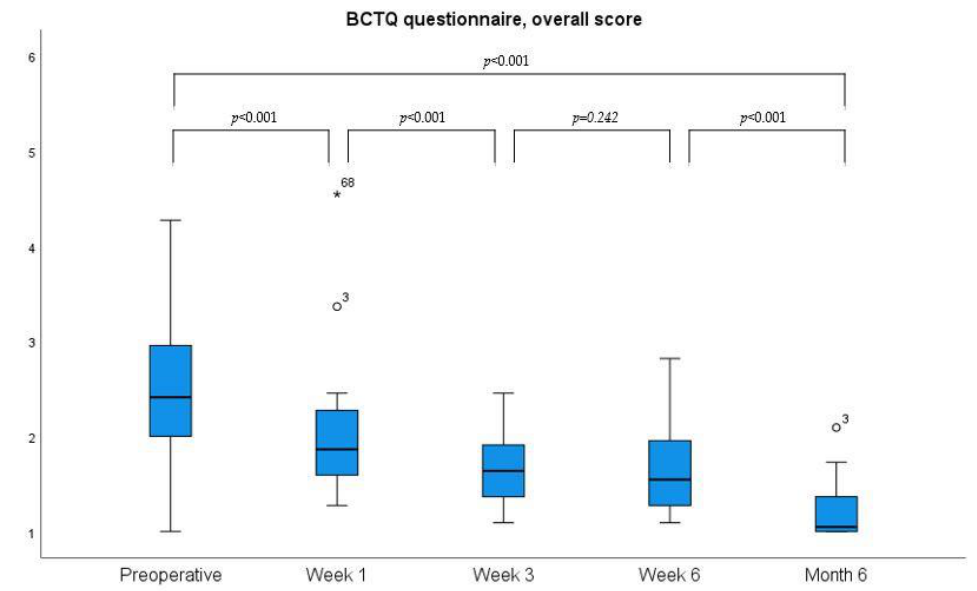
Figure 5. Development of the overall Boston Carpal Tunnel Questionnaire (BCTQ) over time. (* and ° present outliers).